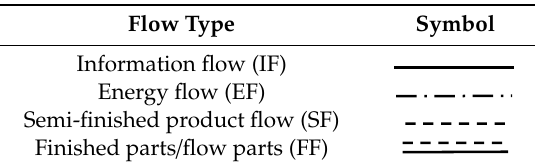
Table 1. Flow symbols.